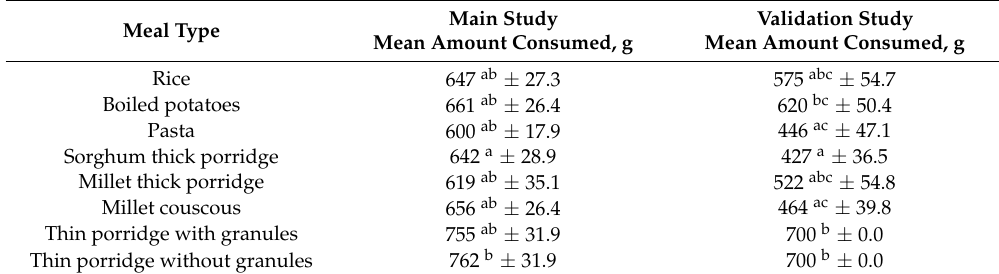
Table 4. Amount of test meals consumed, wet weight (main study ( n = 14); validation study ( n =